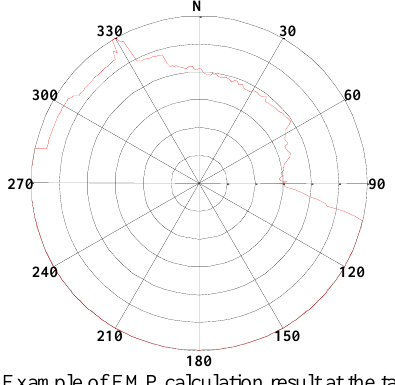
Figure 5. Example of EMP calculation result at the target point in Figure 3